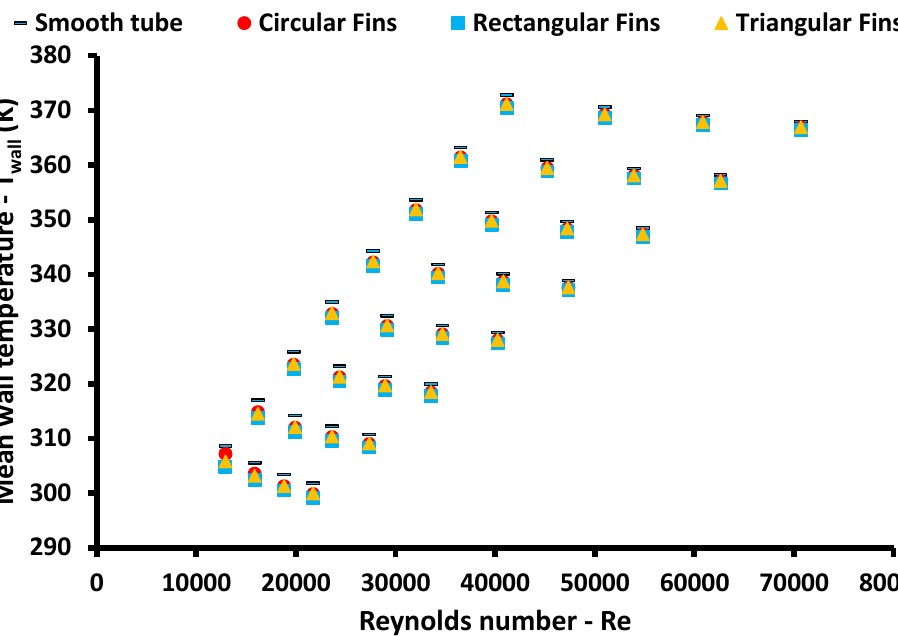
Figure 20. Mean wall temperature in the examined cases for all the tubes.